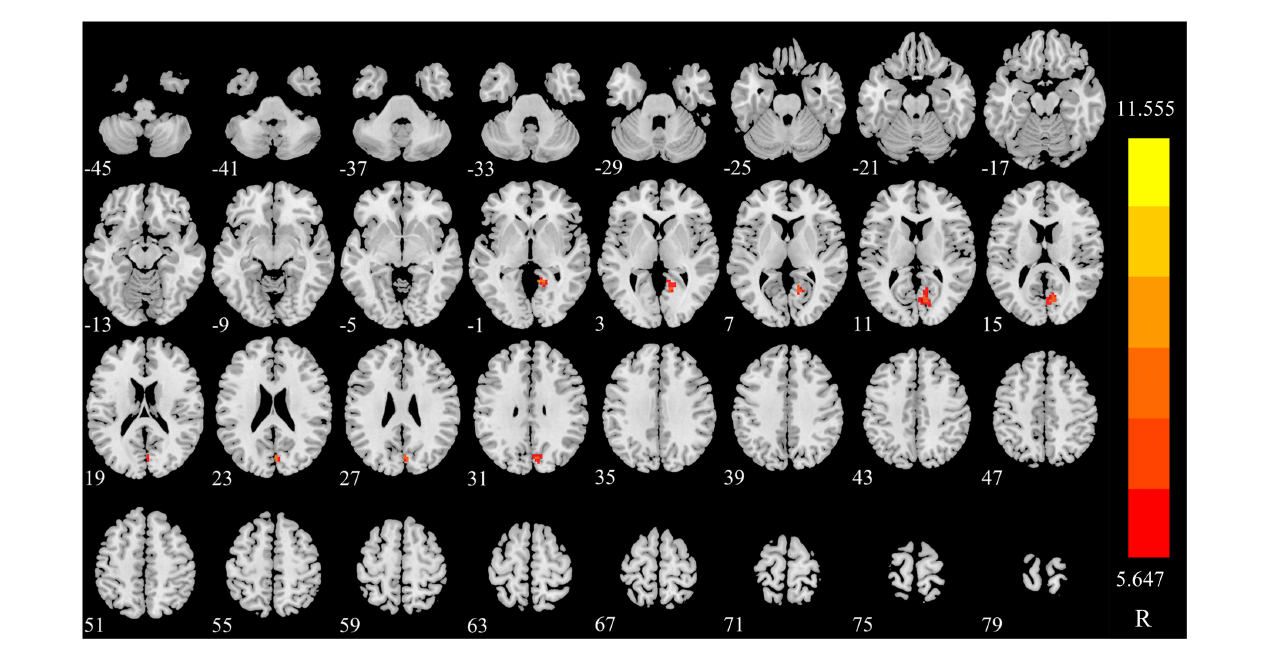
with half height and the full width of 6 mm for spatial